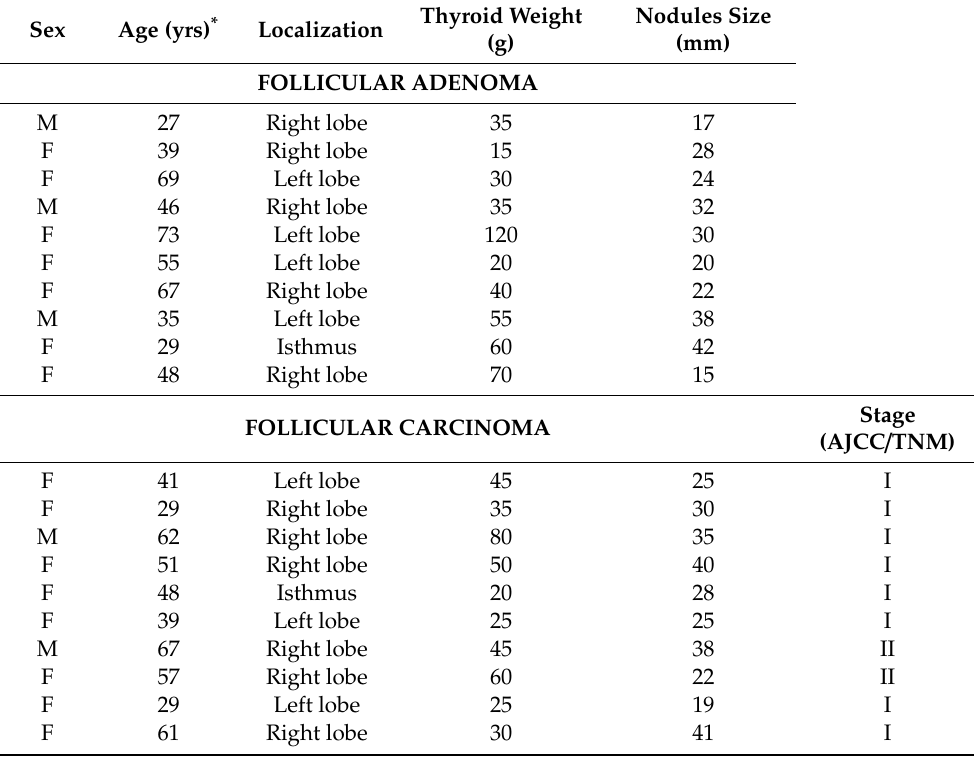
Table 1. Patient demographics and tumor